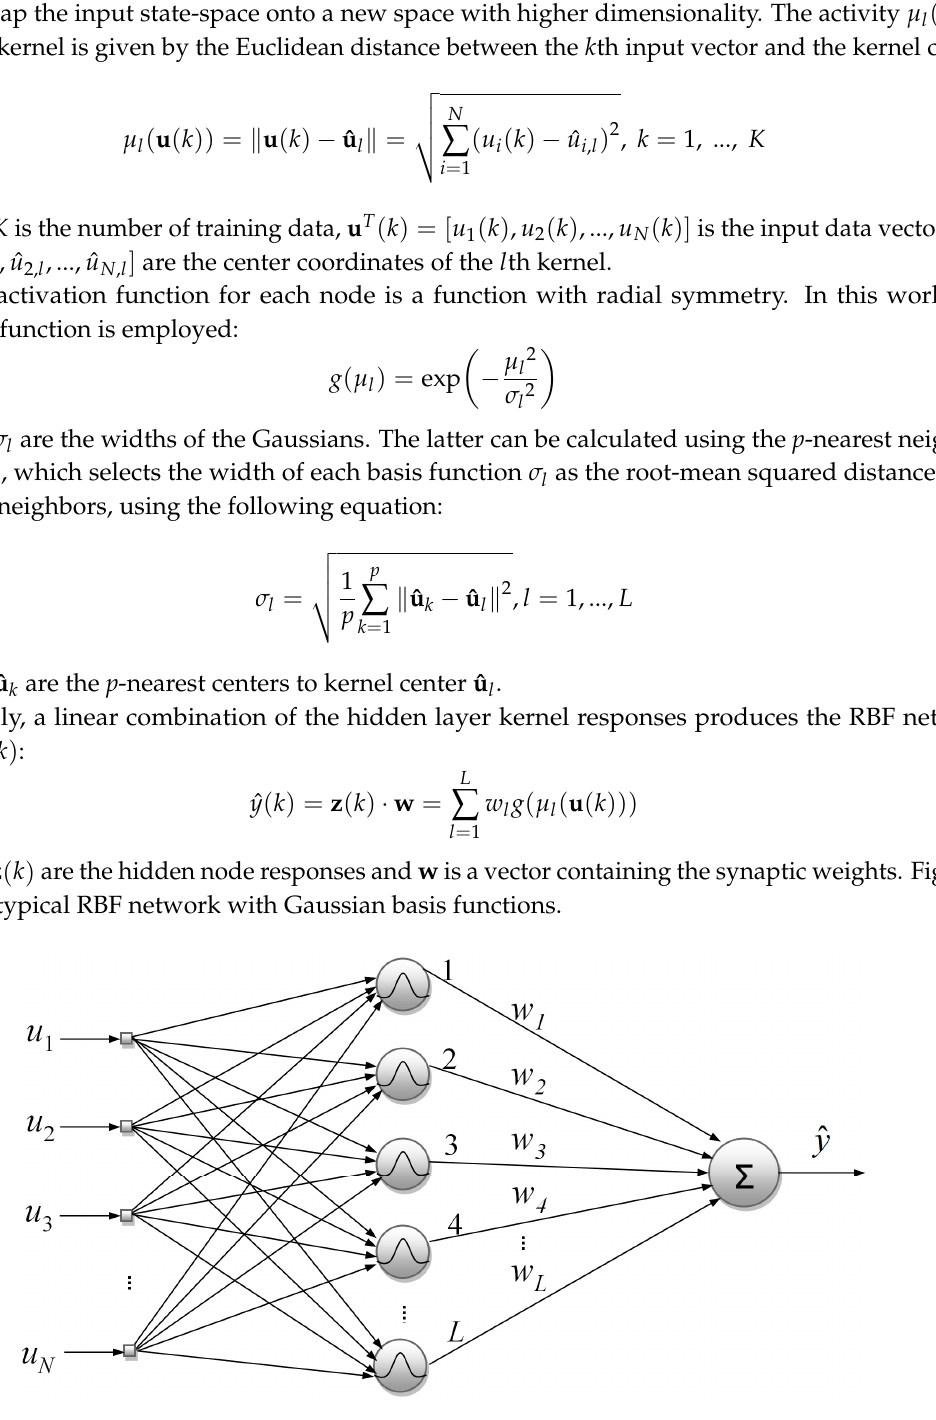
Figure 1. Typical structure of an RBF network with Gaussian basis functions.